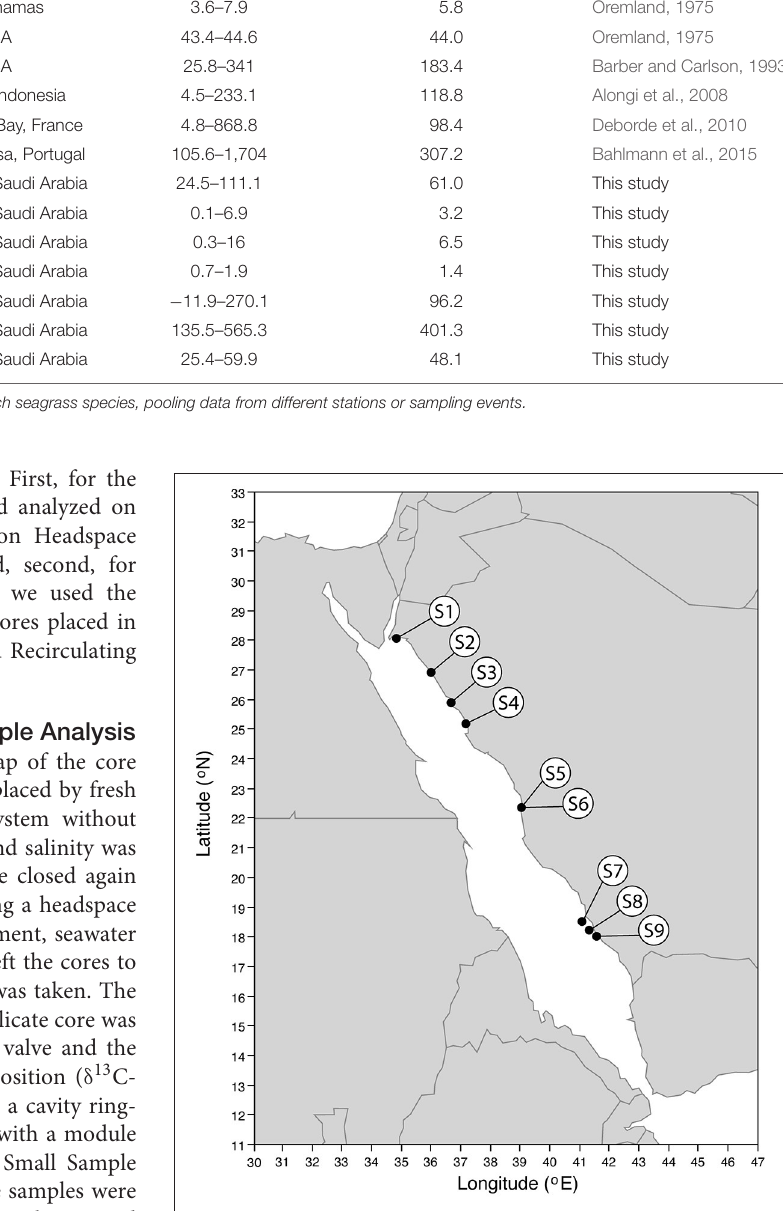
seawater collected from the same location without